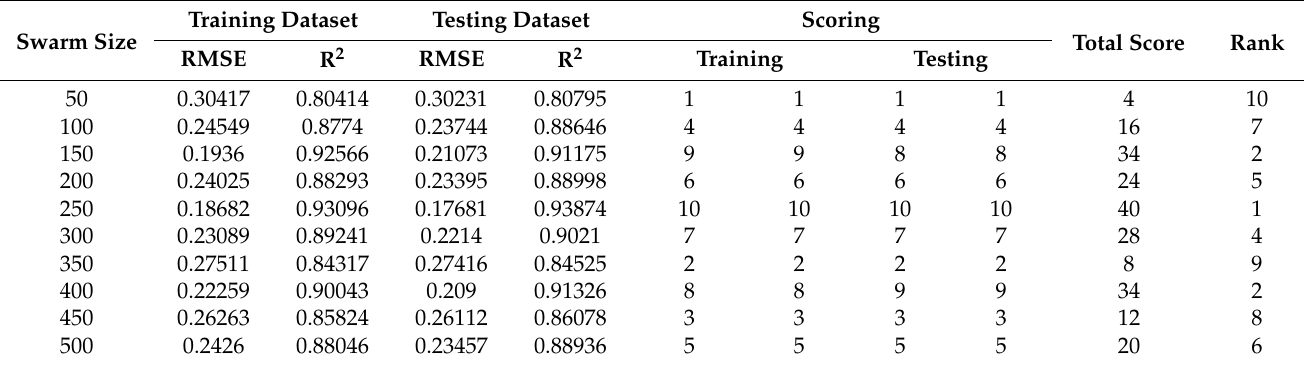
Table 3. The network results for the EWAANFIS for different swarm